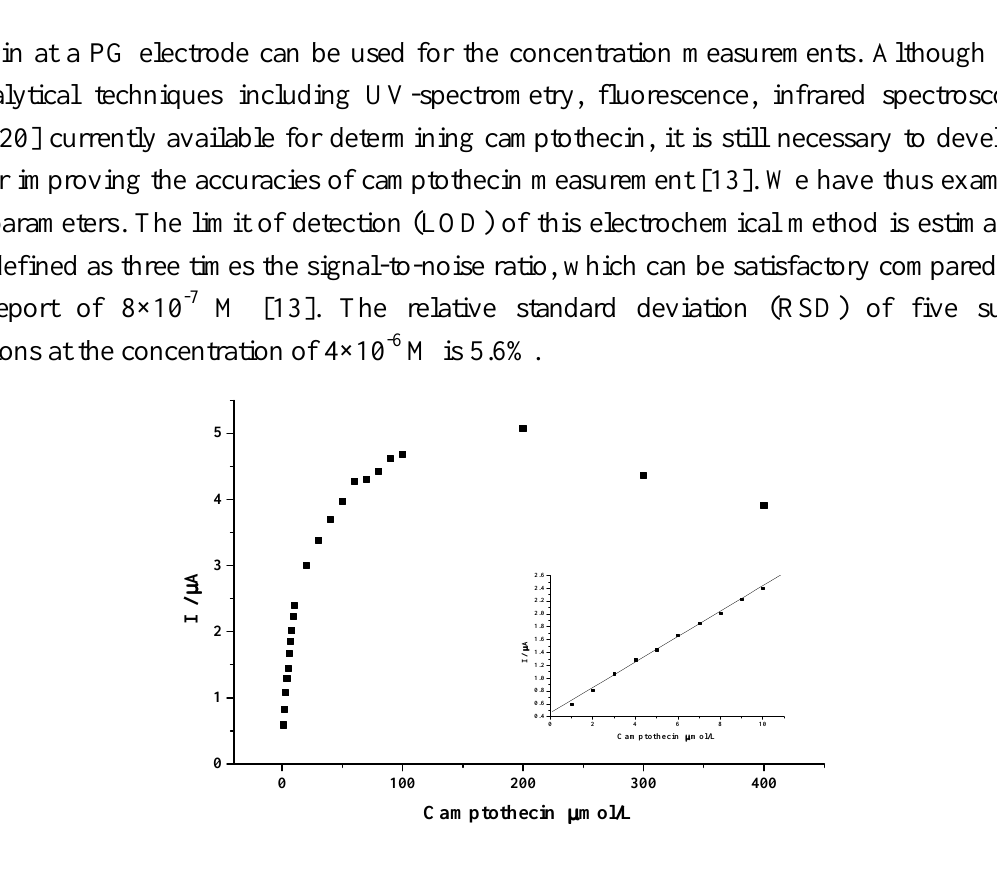
Figure 5. Dependence of the cathodic peak current on the camptothecin concentration. Others same as in Figure 1.